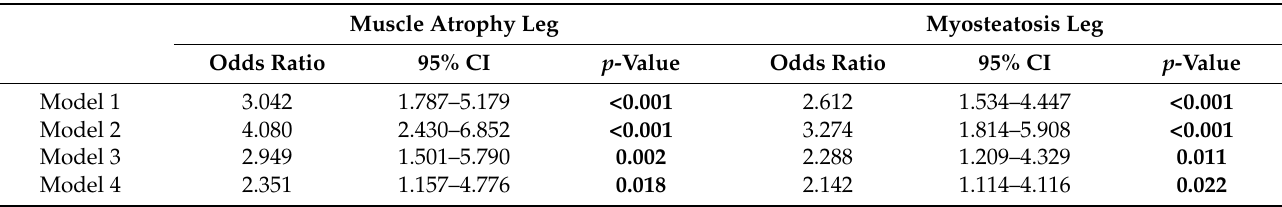
Table 4. Binary logistic regression for the impact of muscle atrophy or myosteatosis on amputation in four models controlled for different risk factors.